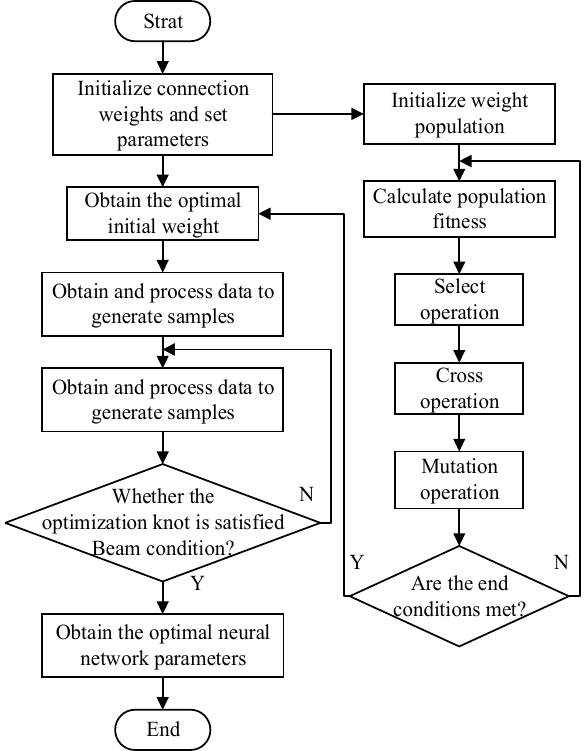
Figure 6. GA optimizes the BP neural network process.